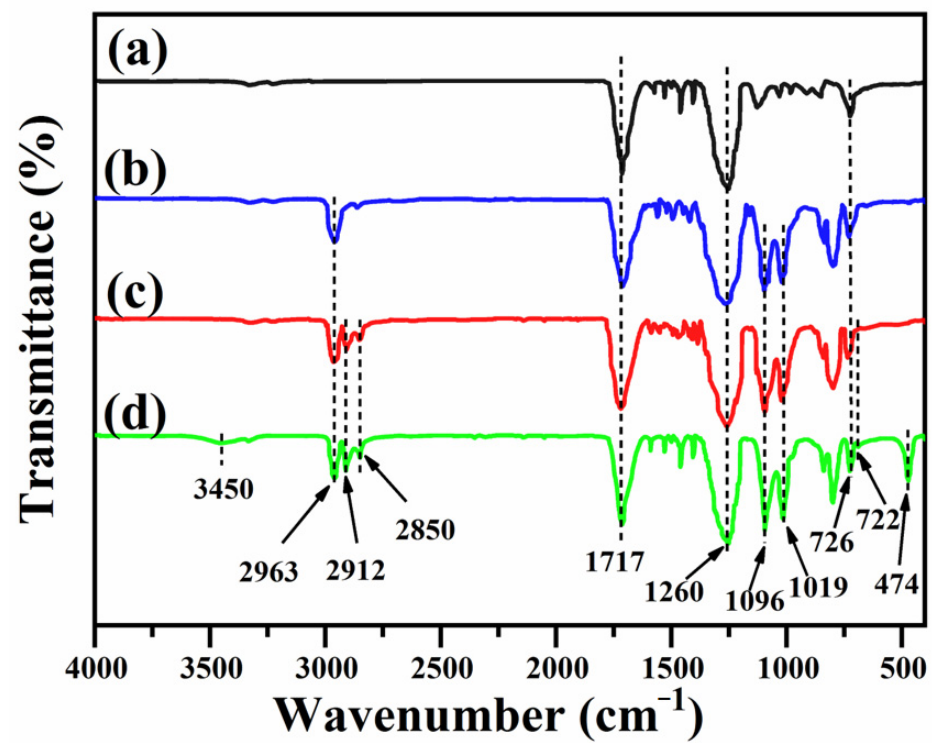
Figure 1. Fourier transform infrared spectroscopy (FTIR) spectra of fabrics: ( a ) pristine fabric, ( b ) PDMS-coated fabric, ( c ) PDMS/STA-coated fabric, and ( d ) PDMS/STA/SiO 2 -coated fabric.